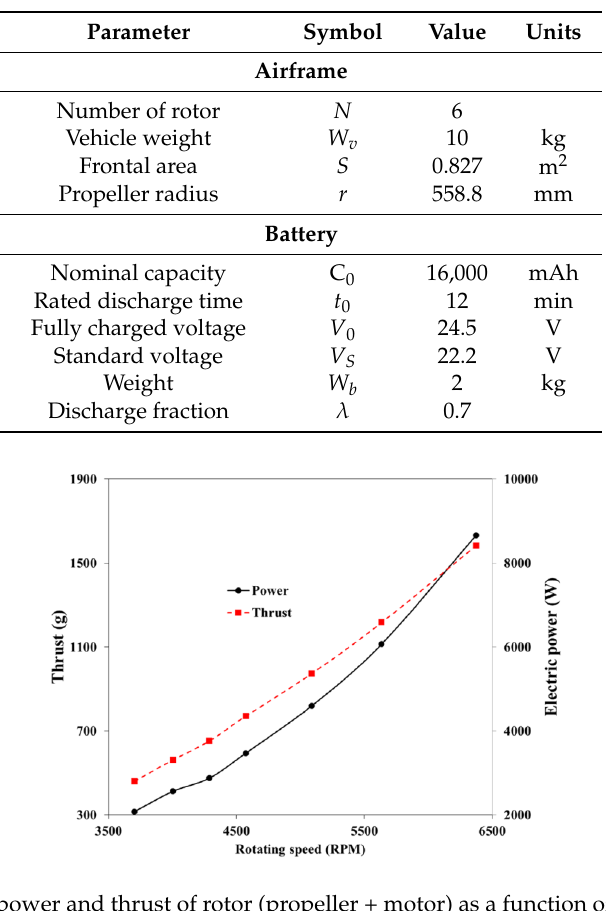
Figure 5. Required power and thrust of rotor (propeller + motor) as a function of the rotating speed which is changed by changing throttle from 50 to 100%. The data is provided by manufacturer.